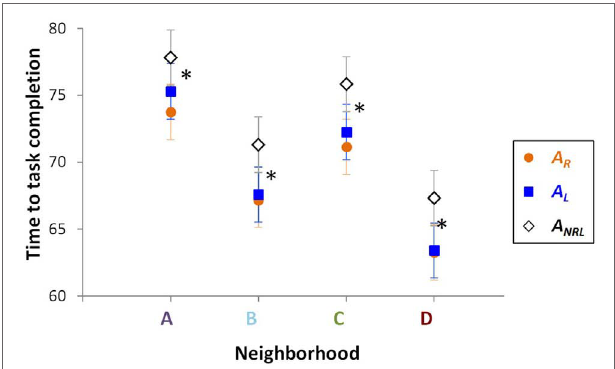
FIGURE 9 | Hebbian–BI (HBI) learning . The three types of agent started from one of 16 different positions, grouped into the same neighborhoods as in Figure 8 . The time for each agent to complete its errand run task was measured. Using a 3 (cid:2) 4 fully factorial ANOVA, a significant ( p < 0.05) effect of type of agent and neighborhood was detected. Post hoc t-tests determined that in all neighborhoods A R and A L were statistically indistinguishable and that both were statistically different from A NRL , as indicated by the asterisks. When the marker for A R is not visible, it is hidden behind the marker for A L